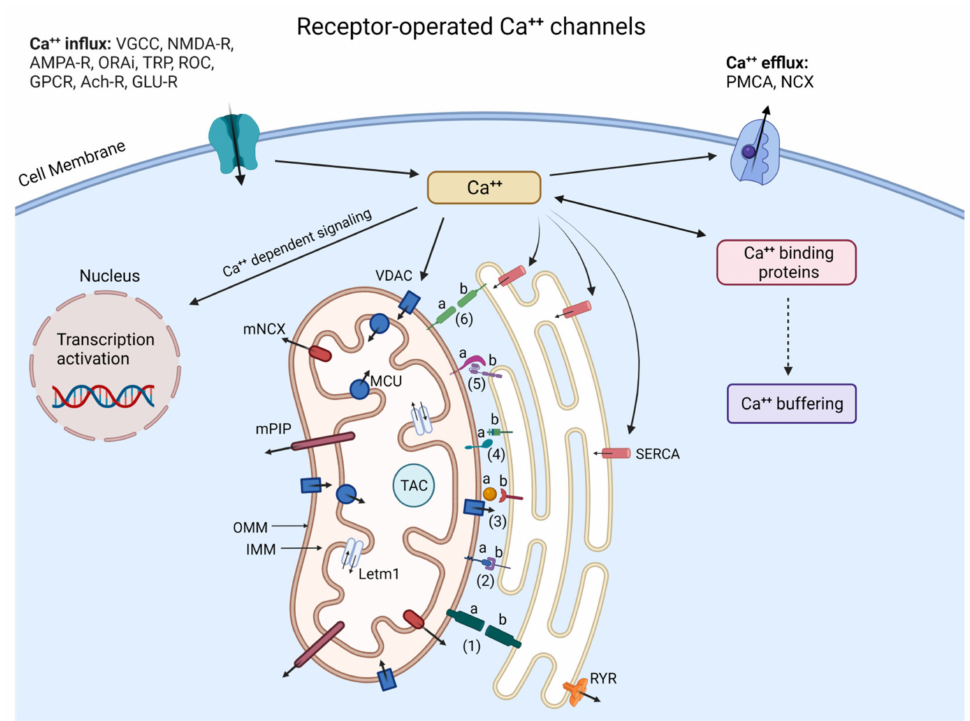
Figure 2. Neuronal Ca ++ homeostasis via Pore/Receptor-operated Ca ++ channels, Ca ++ binding proteins, gene transcription, and ER/Mitochondria interactions. The complex signaling pathways regulating neuronal Ca ++ concentration and organization require various membrane Ca ++ -conducting channels, intracytoplasmic organelles such as ER and mitochondria, and a great number of Ca ++ buffering/dependent proteins including calretinin, parvalbumin, calbindin, and kinases. (Ca ++ ) ic is determined by the balance between Ca ++ influx (left side) and efflux (right side) and is buffered in the cytosol by mitochondria through VDAC, MCU, and ER with the help of SERCA while RyR and IP3R mediate ER Ca ++ efflux. (Ca ++ ) ic also regulates the expression of target genes. Ca ++ released from the ER interacts with mitochondria through MAM and contributes to the activation of the Tricyclic Acid Cycle (TAC) to stimulate ATP synthesis, whereas the excessive transfer of Ca ++ to mitochondria leads to ROS and BAX/BAK-dependent apoptosome. Inter-organelles do not act as autonomous units but as interconnected hubs that engage in extensive communication through membrane contacts. The proteins within MAM—a central hub involved in different fundamental cell processes—play important roles in maintaining MAM stability, Ca ++ transport, and apoptosis: 1a, b: REEP1: Receptor expression-enhancing protein 1 (REEP1); 2a: PTPIP51; 2b: VABP; 3a: GrP75; 3b: IP3R; 4a: Protein tyrosine phosphatase interacting protein1 (PTPIP51); 4b: Motile sperm domain-containing protein 2 (MOSPD2); 5a: MFN1; 5b: MFN2; 6a,b: MFN2. Yet, the depletion of the Σ − 1 receptor leads to abnormal Ca ++ signaling between ER and mitochondria, and the disruption of ATP